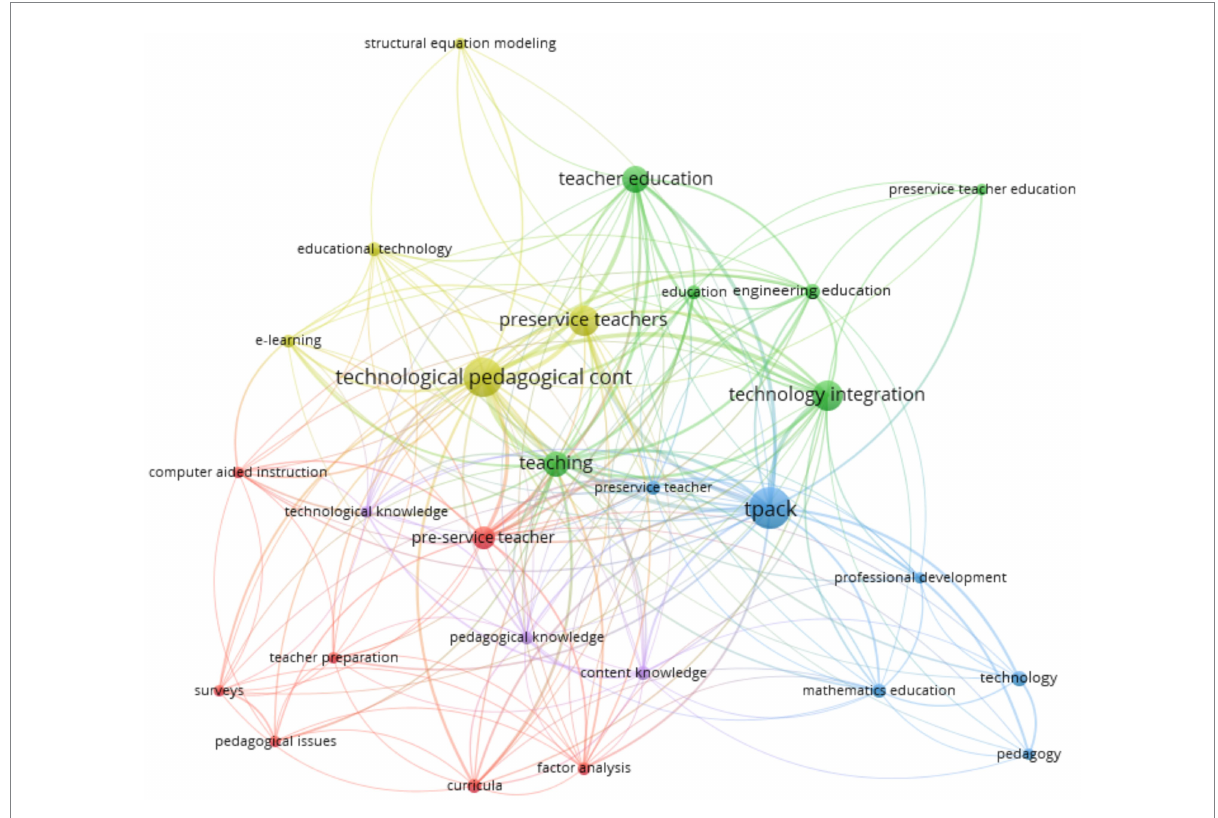
FIGURE 4 Keywords using